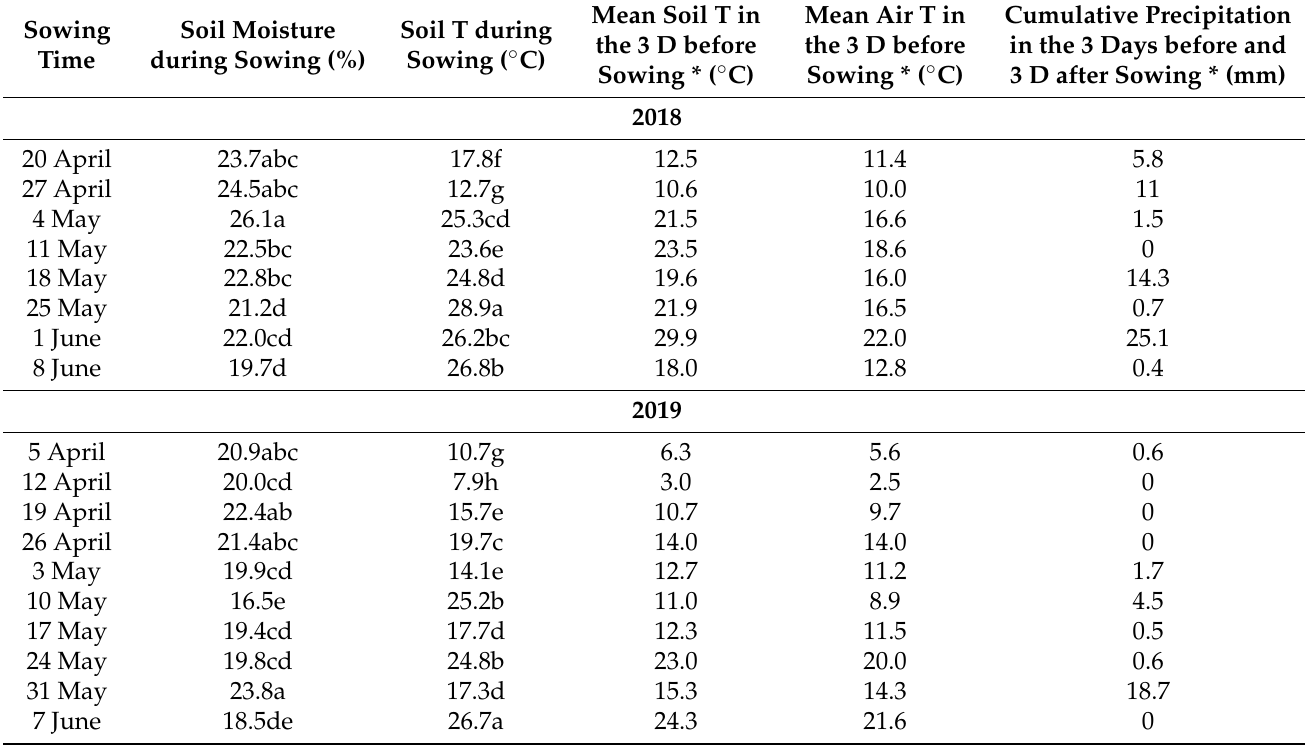
April compared to the later sowings. Table 2. Soil moisture, temperature, and weather conditions during the sowing and during 3 days before and 3 days after the rapeseed sowing from